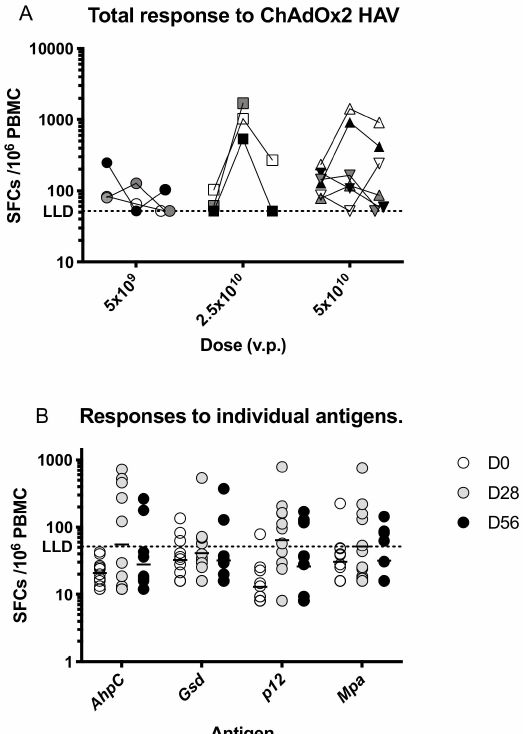
Figure 3. T cell responses to ChAdOx2 HAV. ( A ) Summed interferon- γ (IFN γ ) enzyme-linked immunospot (ELISpot) responses to the vaccine insert stratified by dose and time point. Prior to vaccination, responses to HAV antigens were low, with a geometric mean response of 109 (95% CI 79–151) spot-forming cells (SFC) per million PBMC. Responses increased significantly at day 28 in the group that received 2.5 × 10 10 vp compared with responses in all participants at day 0 ( p < 0.05, Kruskal-Wallis test with Dunn’s correction for multiple comparisons). No other comparisons were statistically significant. ( B ) Responses to individual antigens encoded in the vaccine insert at each time point. Lines represent geometric means. Vp, viral particles. LLD, lower limit of detection for the ELISPOT